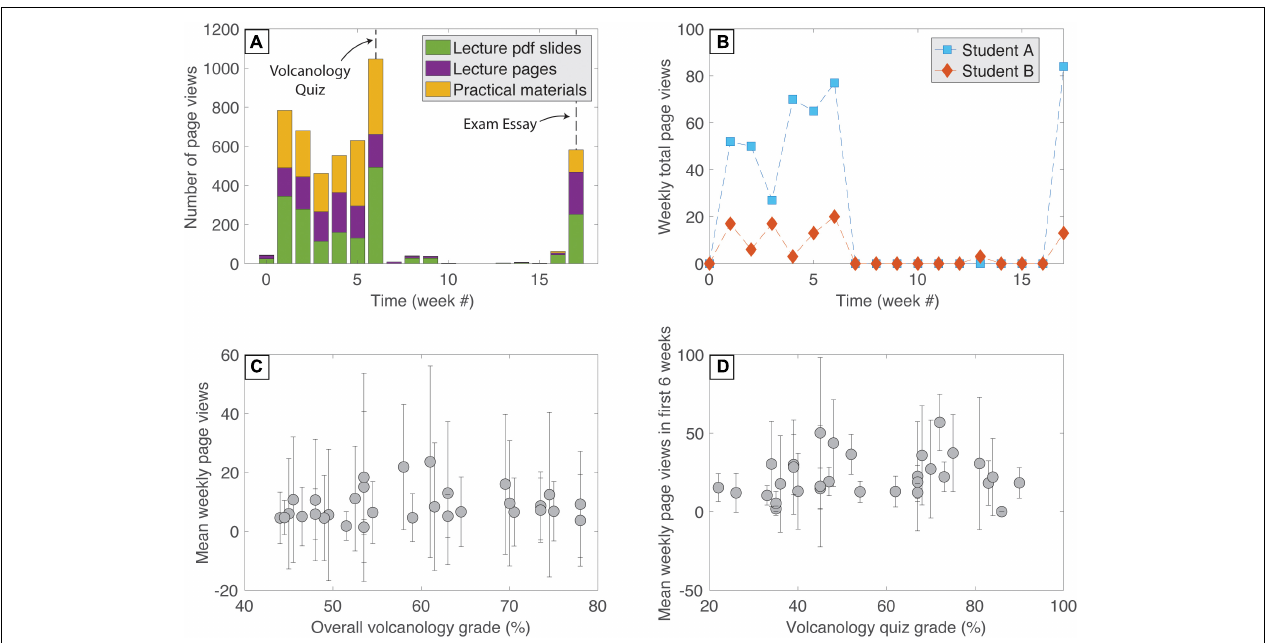
FIGURE 4 | Time series of VLE access. (A) The total number of page views per week. The green shaded parts of the bar correspond to the pdf copies of the lecture slides. Purple corresponds to the VLE pages with the lecture video embedded and yellow corresponds to the practical question sheets and answers. Teaching began in week 1 and lasted for 5 weeks, the volcanology quiz was conducted in week 6 and the final essay-based exam was conducted in week 17. (B) Total number of page views as a function of week for two representative students. (C) Mean number of weekly page views compared to the overall volcanology grade obtained. (D) Mean number of weekly page views during weeks 1 through 6 compared to the volcanology quiz grade obtained. In both panels (C,D) the error bars represent one standard deviation of the student’s page views for weeks 0–17 and for weeks 1–6,